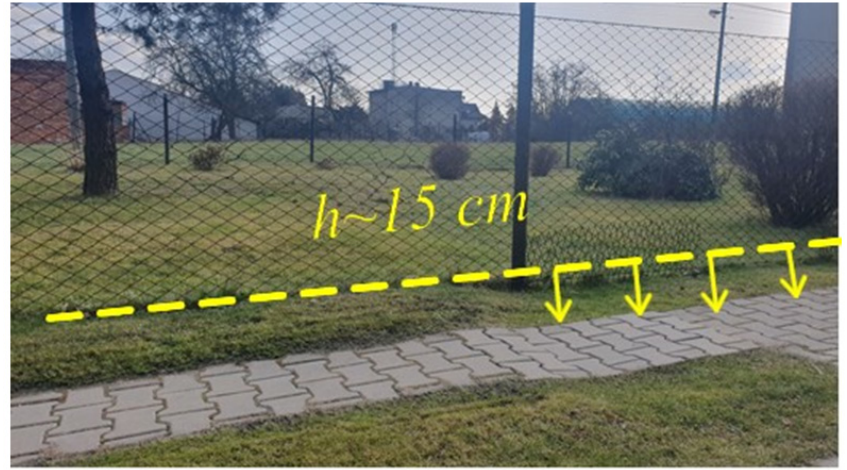
Figure 9. Discontinuity number 3—view to the east from the building; h—the height of the fault drop.